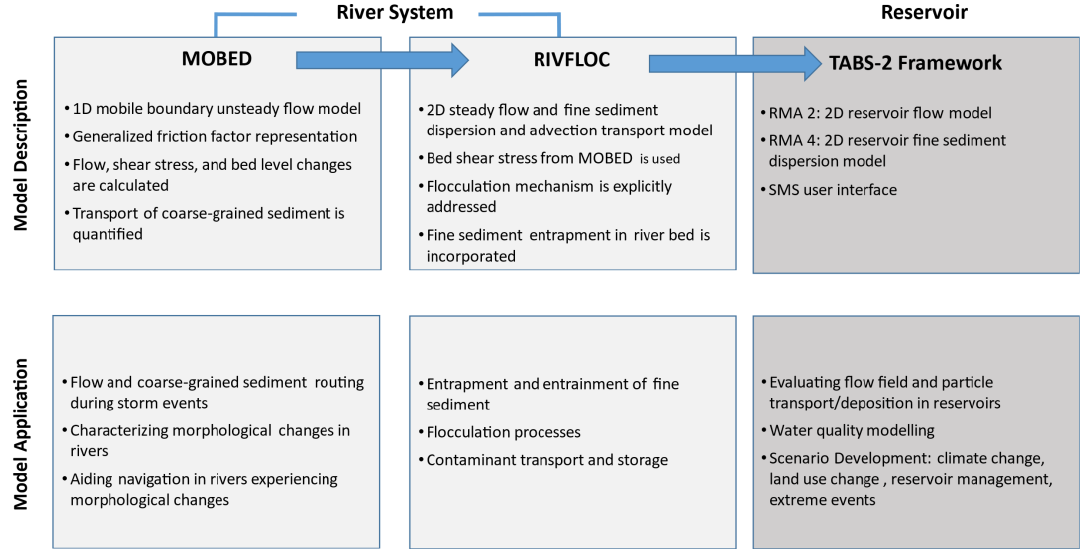
Figure 2. Schematic of the modelling framework.